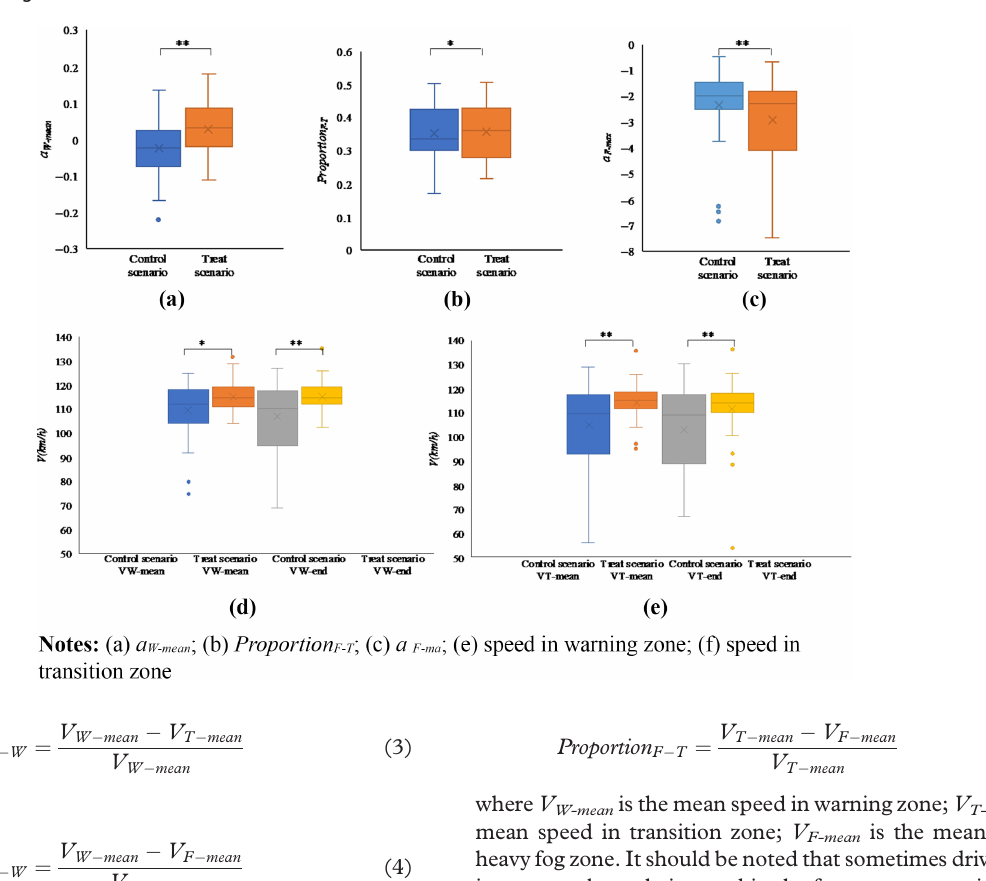
represent a reduction ratio of the